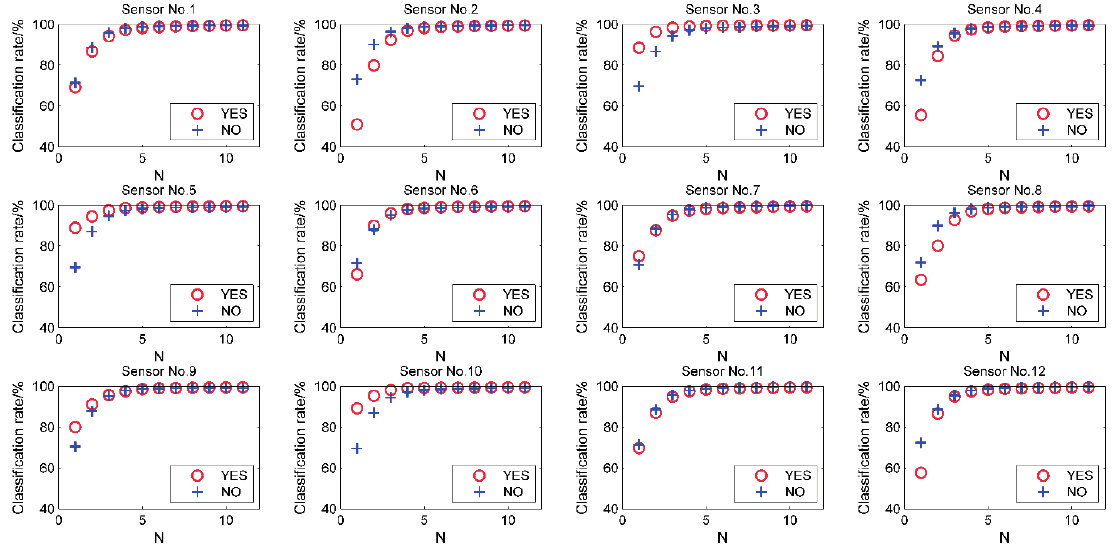
Figure 5. The first step of comparison of average classification performance ( A2 ) of sensor sets including certain sensor with that not including it for sensor number of N = 1 to 11. ‘YES’ means including, ‘NO’ means not